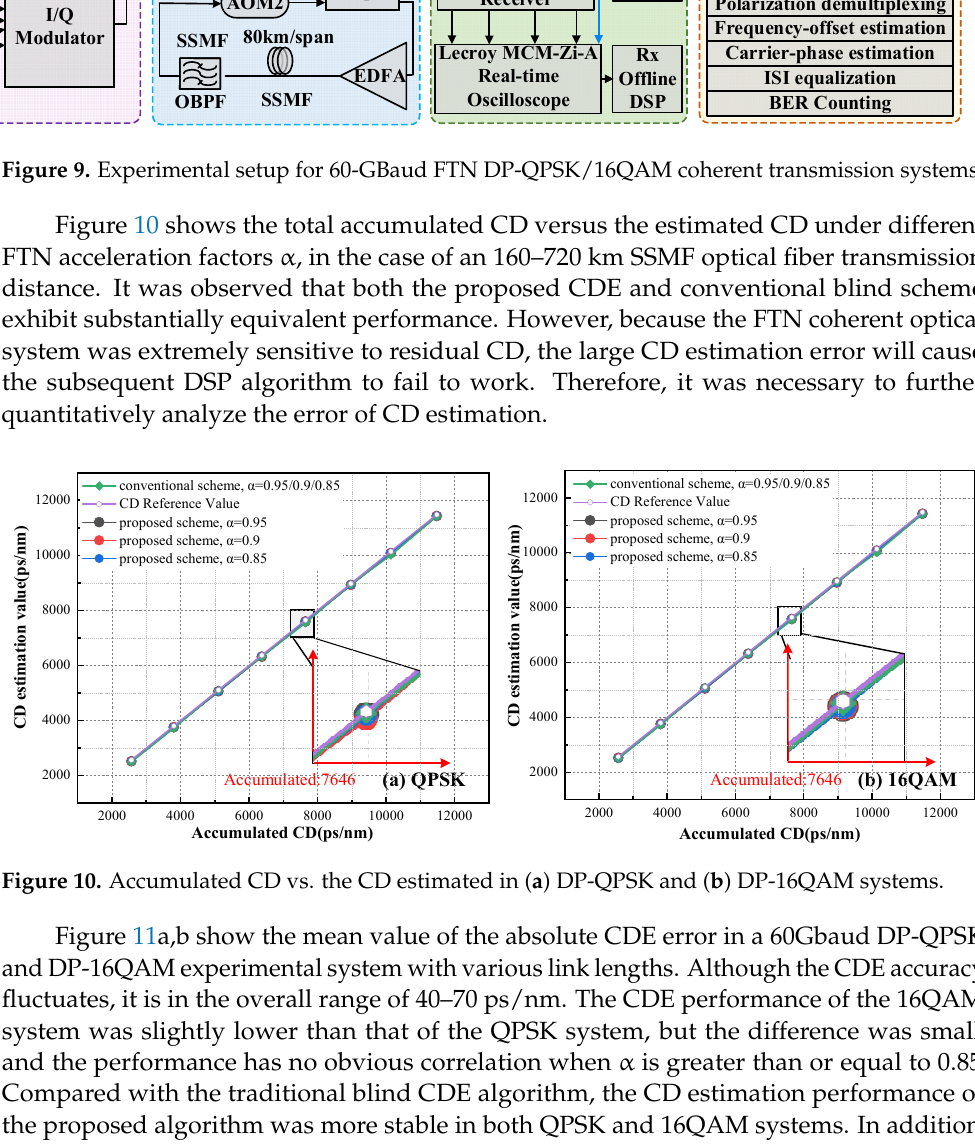
Figure 10. Accumulated CD vs. the CD estimated in ( a ) DP-QPSK and ( b ) DP-16QAM systems. Figure 11a,b show the mean value of the absolute CDE error in a 60Gbaud DP-QPSK and DP-16QAM experimental system with various link lengths. Although the CDE accu- racy fluctuates, it is in the overall range of 40–70 ps/nm. The CDE performance of the 16QAM system was slightly lower than that of the QPSK system, but the difference was small, and the performance has no obvious correlation when α is greater than or equal to 0.85. Compared with the traditional blind CDE algorithm, the CD estimation performance of the proposed algorithm was more stable in both QPSK and 16QAM systems. In addi- tion, as is consistent with the simulation, the CDE error of the blind CDE algorithm varied